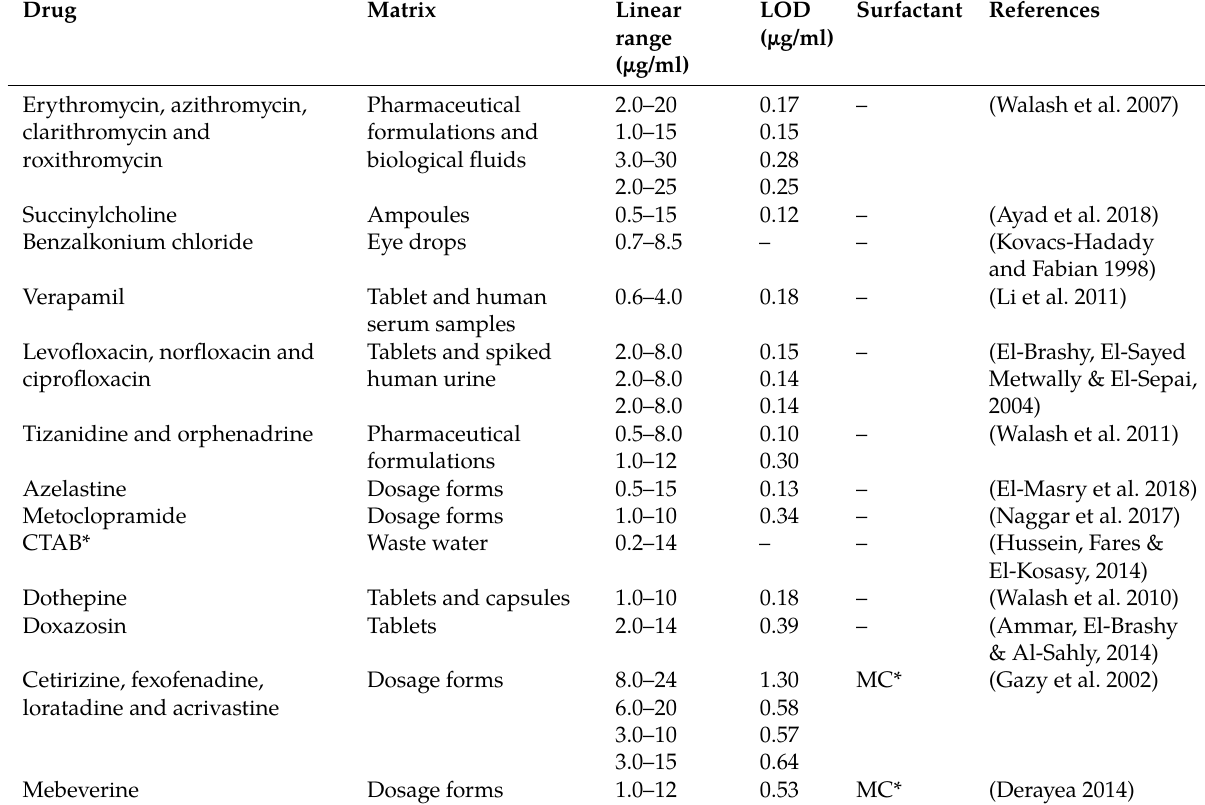
Table 1: The reported spectrophotometric methods for the determination of pharmaceutical compounds based on the binary complex formation with